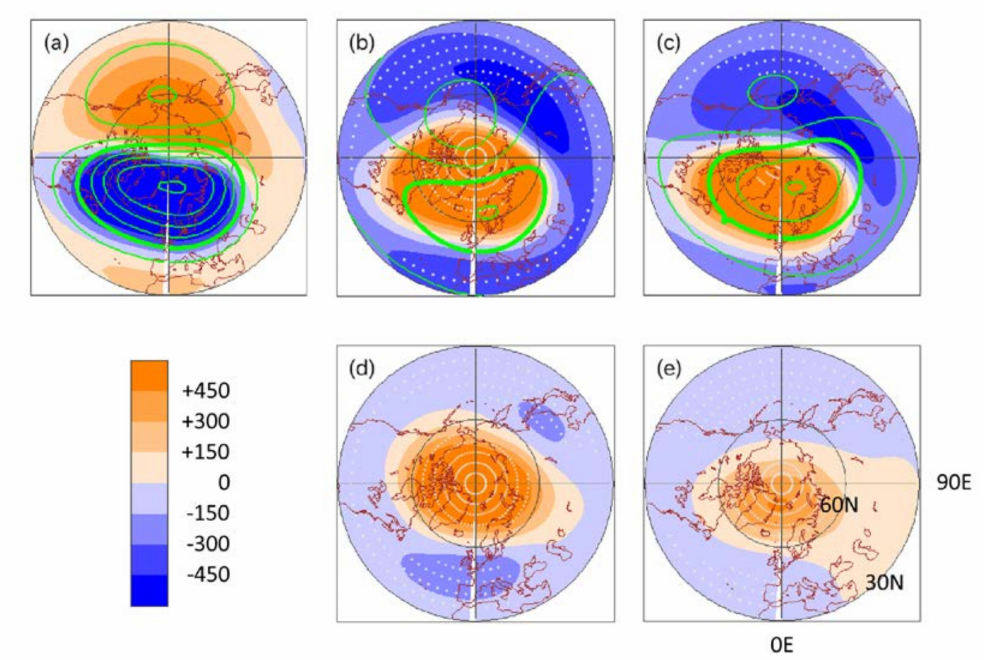
Figure 10. Same as Figure 4, but using the J11 initialization for the second cluster. Panel ( a ) plots the JRA-55 data, ( b ) MSSW member mean, and ( c ) non-MSSW member mean. Panel ( d ) plots the di ff erence of ( b ) from ( c ). Panel ( e ) plots the regression field onto the heat flux. There are 29 MSSW members and 21 non-MSSW